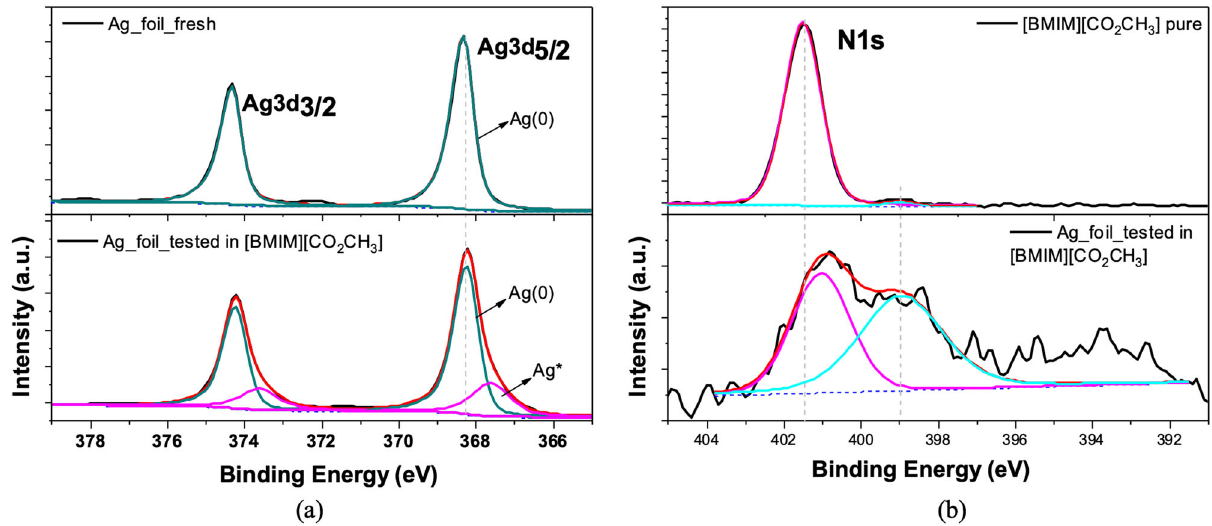
Fig. 5 XPS spectra of the [BMIM][CO 2 CH 3 ] electrolyte and working electrode after test. a Ag3d high resolution XPS spectra for the electrode before (upper panel) and after (lower panel) the electrochemical test. b N1s high resolution XPS spectra of the pure [BMIM][CO 2 CH 3 ] IL (upper panel) and the tested electrode (lower